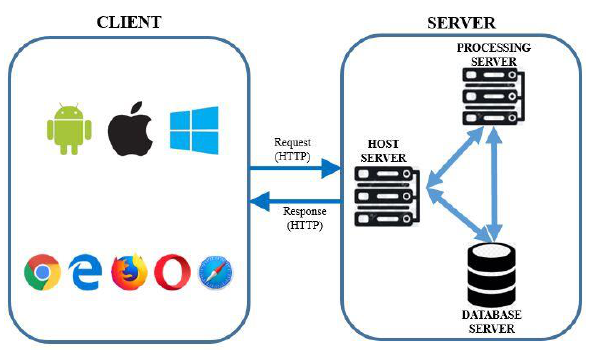
Figure 9: The architecture of the new application Beside creating a free and open source application, the idea is also to use free and open source software and libraries while developing it. As a reference, the Land Cover Collector smartphone and web application is considered (Brovelli, et al., 2018), which has been developed in the framework of free and open source software. The Land Cover Collector is based on